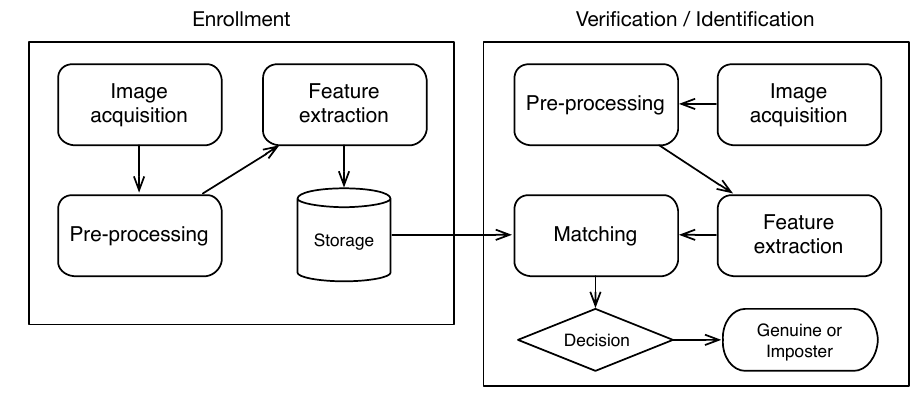
Figure 2. General scheme of a palm vein recognition